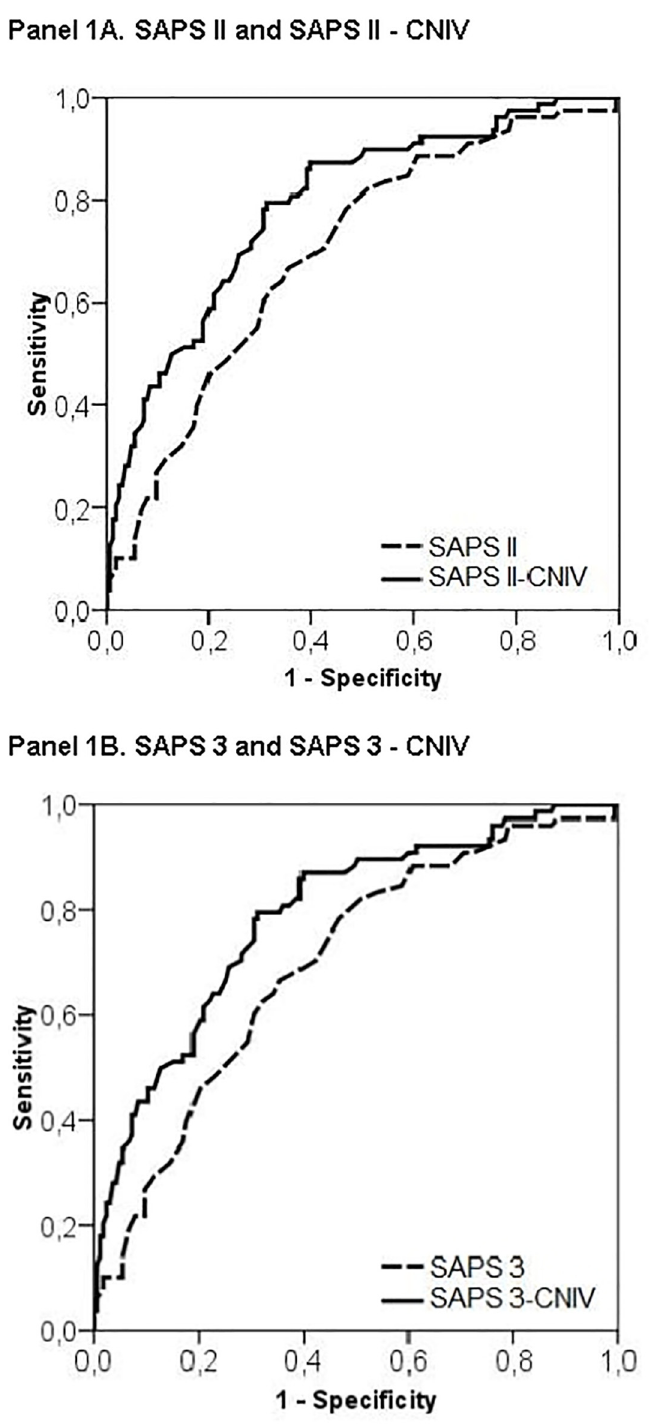
Fig 1. Receiver Operating Characteristic curves in the different prognostic models. (A) SAPS II and SAPS II-CNIV. (B) SAPS 3 and SAPS 3-CNIV.